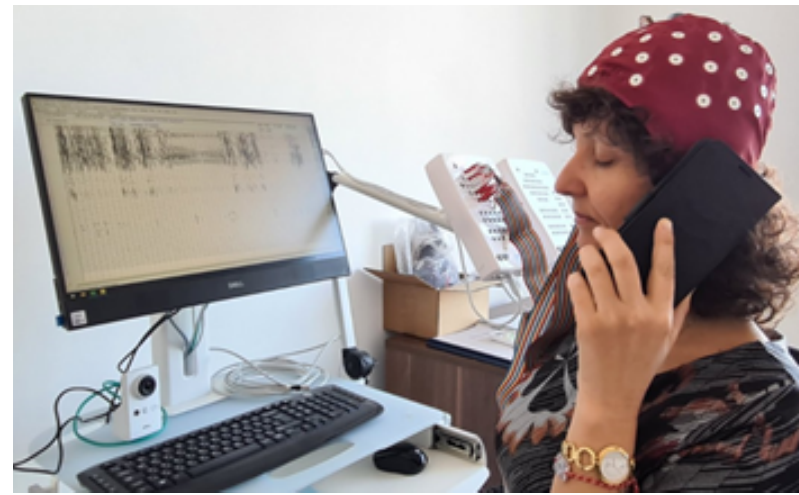
Figure 6. Participant during the experiment.